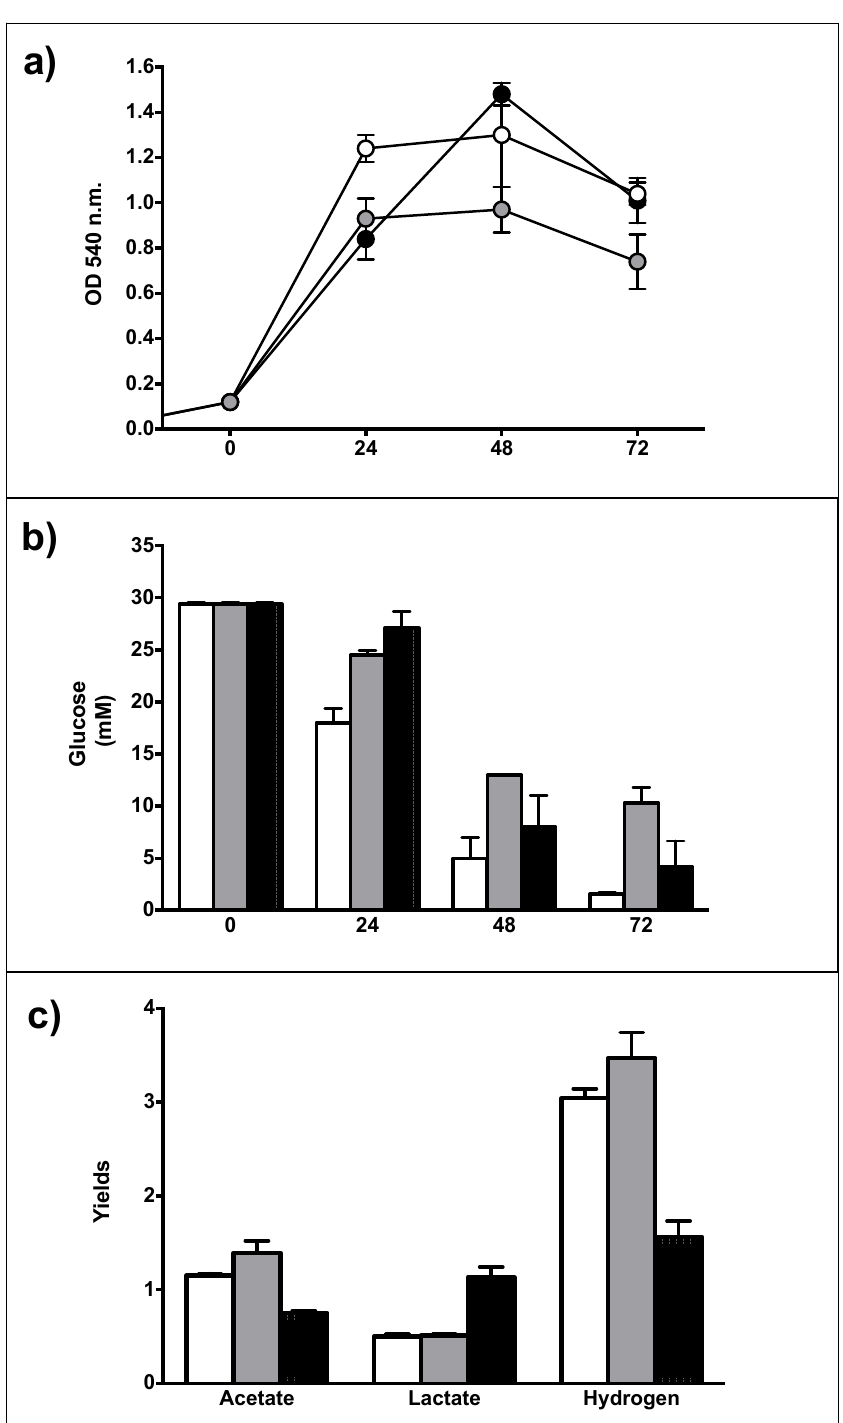
Figure 2. Batch fermentations of wild type (white circle/bars), empty vector (grey circle/bars) and ACS recombinant strain (black circle/bars) after 72 h in static condition. ( a ) Growth curves, expressed as OD 540nm ; ( b ) Glucose consumption, expressed as mM; ( c ) Fermentation products, expressed as yield (mmol product/mmol consumed glucose). Chloramphenicol was used at 200 µ g/mL for selection of recombinant strains. Data are expressed as mean ± SD, n = 3. Cells transformed with the empty vector showed a slowdown in growth compared to wt, probably due to a slight effect of the backbone plasmid including antibiotic re- sistance (Figure 2a). This influence was overcome in the Acs03 recombinant strain, proba-